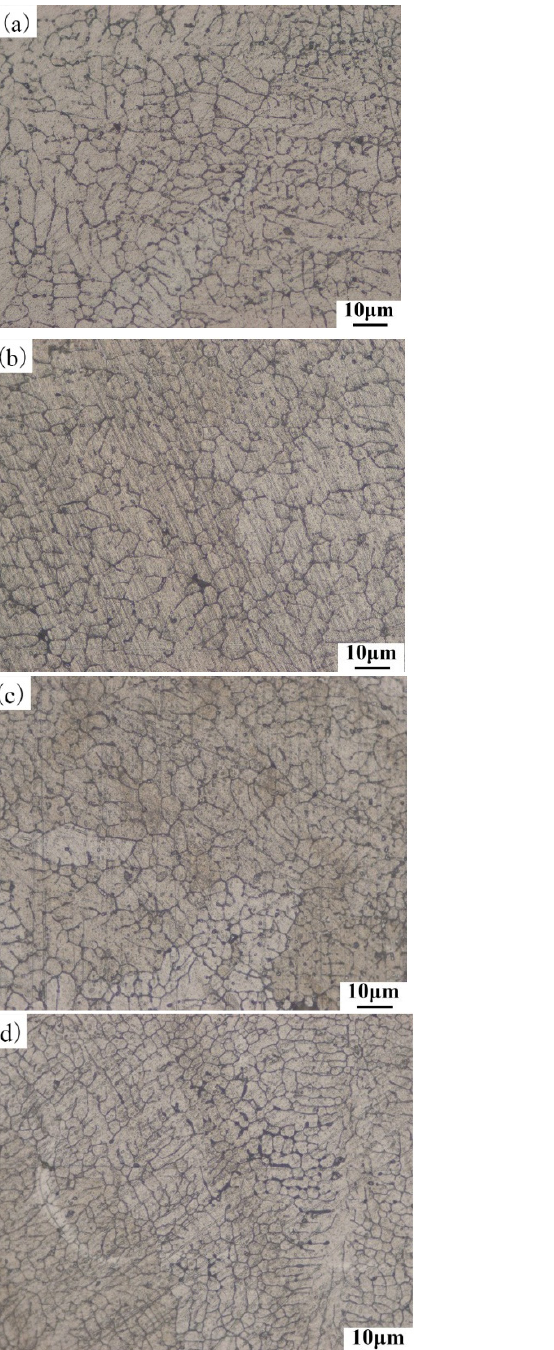
Figure 6. Microstructure and grain size distribution of OABs: ( a ) and ( a-1 ) 128 A; ( b ) and ( b-1 ) 160 A; ( c ) and ( c-1 ) 192 A;